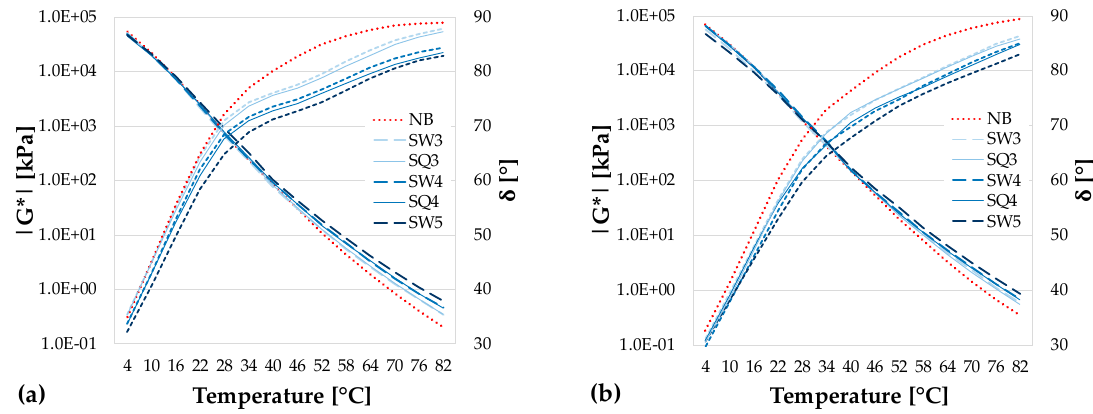
Figure 4. Complex modulus and phase angle isochrones (at 10 rad/s) of SBR-modified binders: ( a ) unaged binders; ( b ) Rolling Thin Film Oven (RTFO)-aged binders.